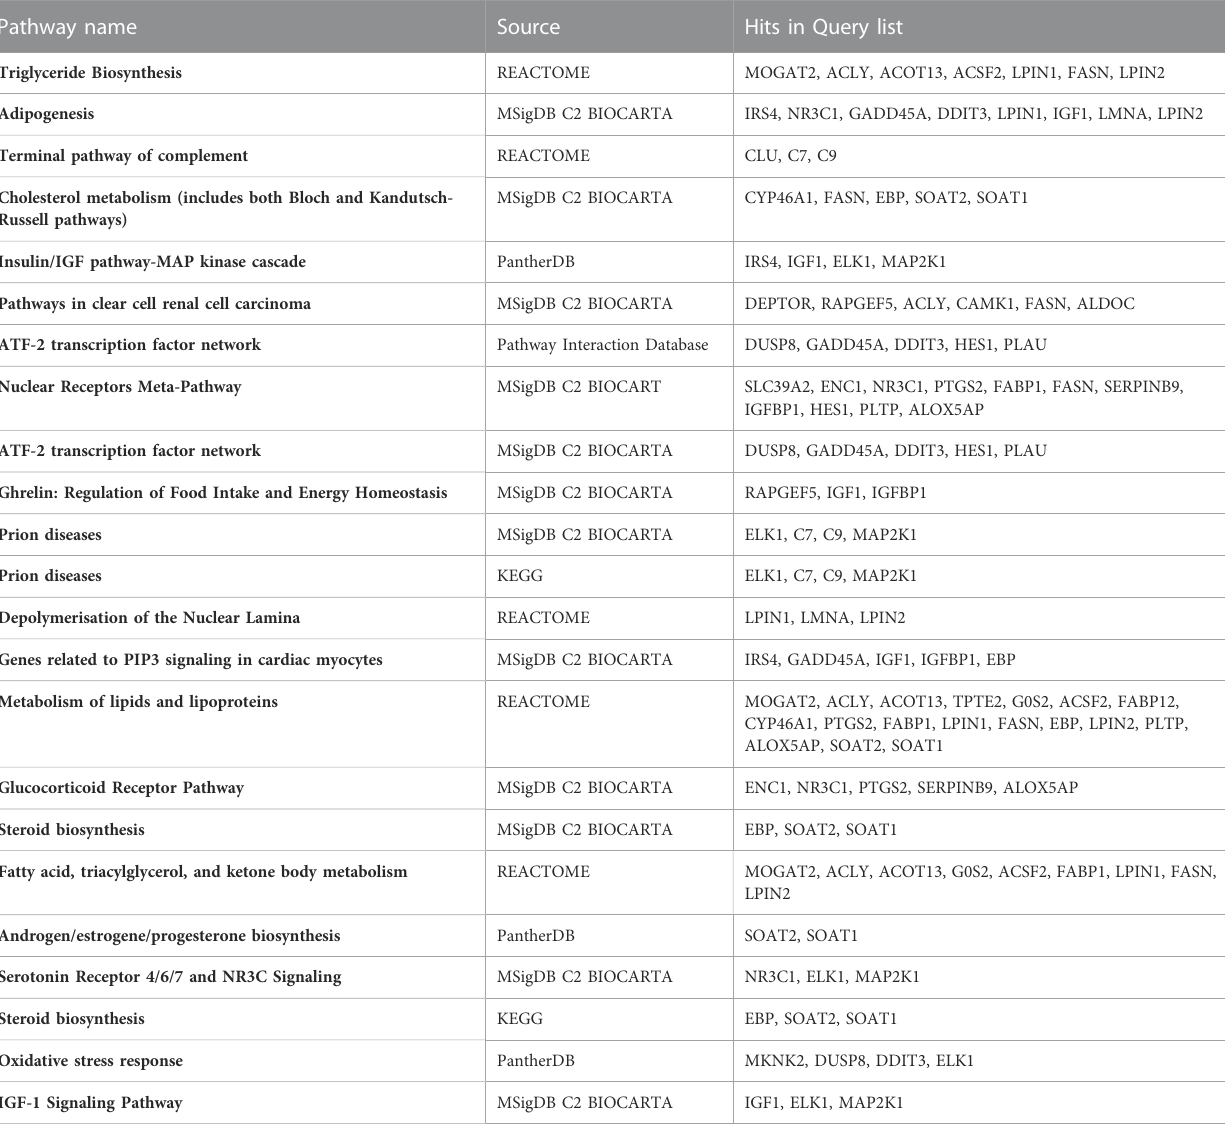
TABLE1Signi fi cantlyenriched (FDRqvalue < 0.05)pathways indifferentiallyexpressedgenesfromtreatment withWY-14,643. Genelists fromlowandhigh-dose treatments were combined in the analysis. Analysis was performed using ToppGene